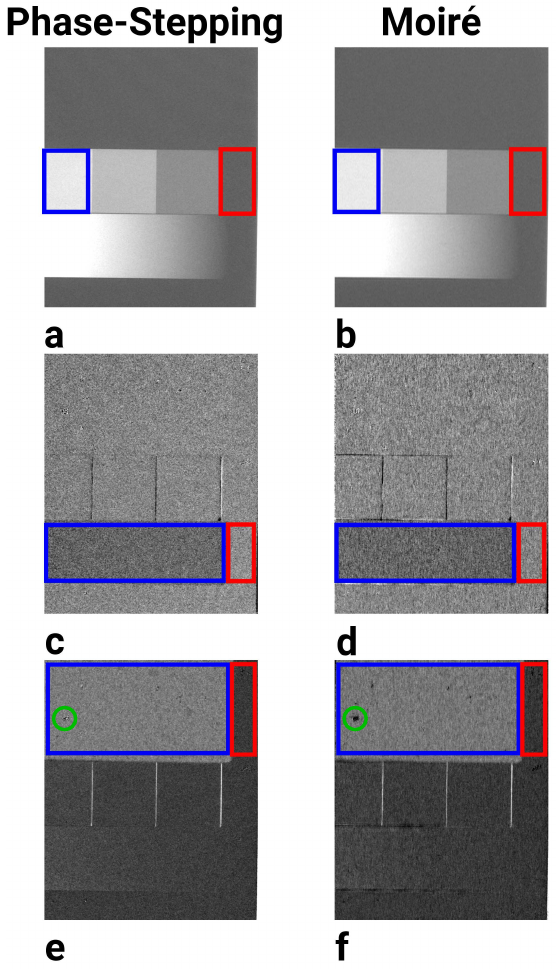
Figure 9. Images of the phantom shown in Figure 3 (red marked area). The ROIs that have been chosen to calculate the CNR values in Table 3 are shown. In the left column ( a , c , e ), the images are obtained using the phase-stepping approach, in the right column ( b , d , f ), the images are obtained using the moiré imaging approach. The attenuation images ( a , b ), the differential phase-contrast images ( c , d ) and the dark-field images ( e , f ) are shown. The green circle in the dark-field images ( e , f ) mark an artifact that is more emphasized in the moiré imaging